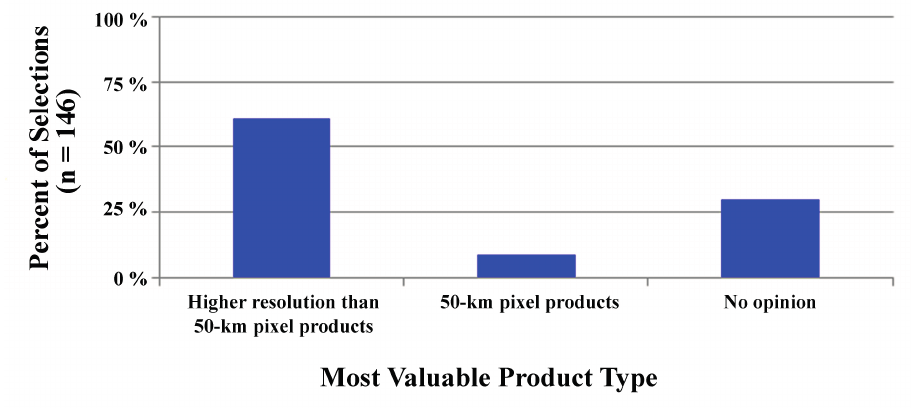
Figure 1. Results of user needs survey conducted by the University of Colorado Cooperative Institute for Research in Environmental Sciences in 2010 indicating the overwhelming request for higher-resolution Coral Reef Watch (CRW)